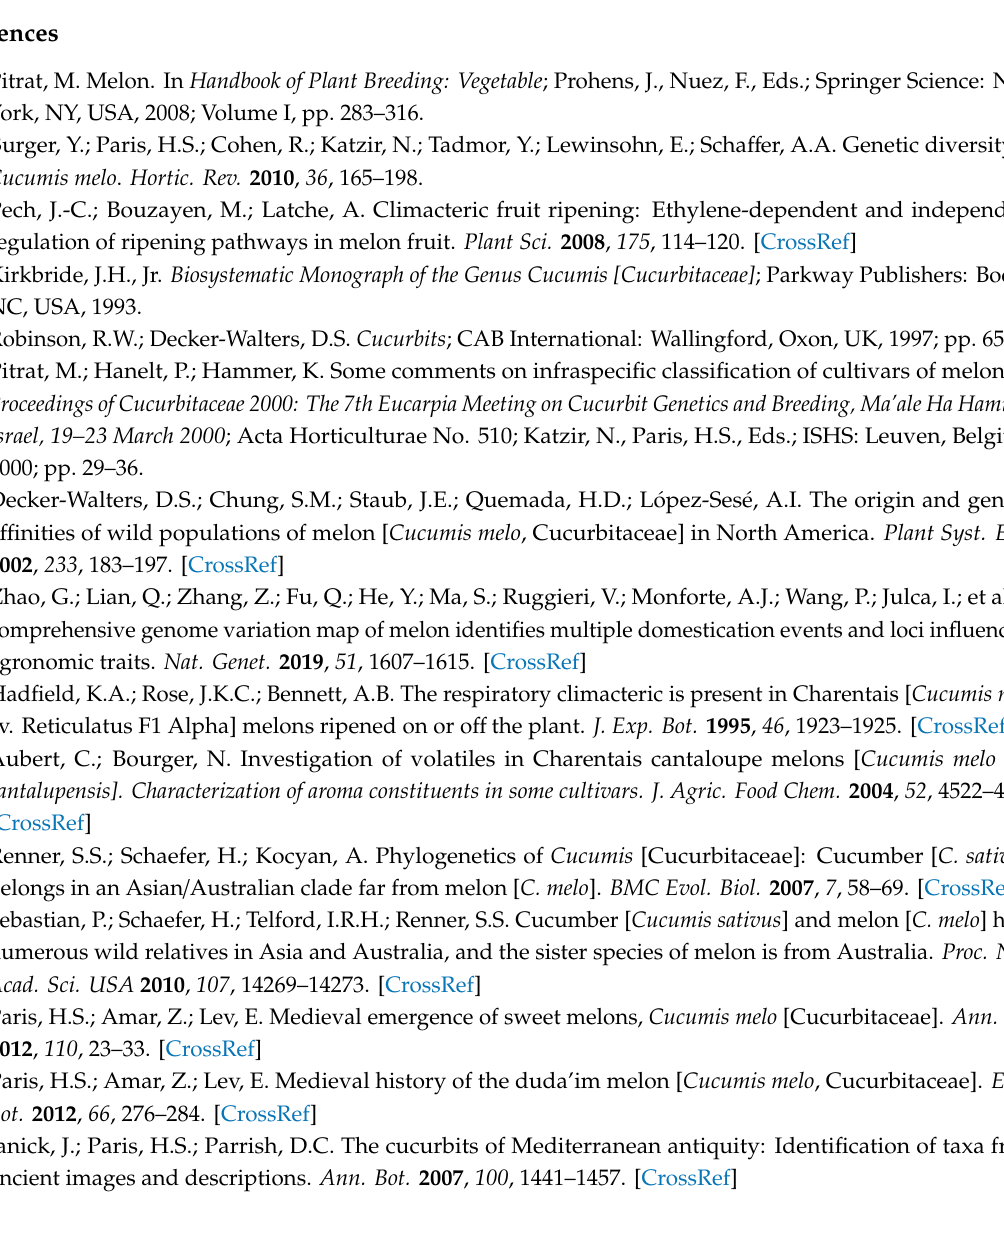
analysis of 52 accession samples performed per analytical platform for fruit rind, Table S1: Description of the melon accessions used in this study, Table S2: Genes and primers used for PCR-based genome sequencing and polymorphism identification, Table S3: Genetic distance matrix of the 44 GBS-sequenced accessions, Table S4: List of 605 provisionally-annotated molecular features from the combined data set with assignment of variable-importance obtained by RF